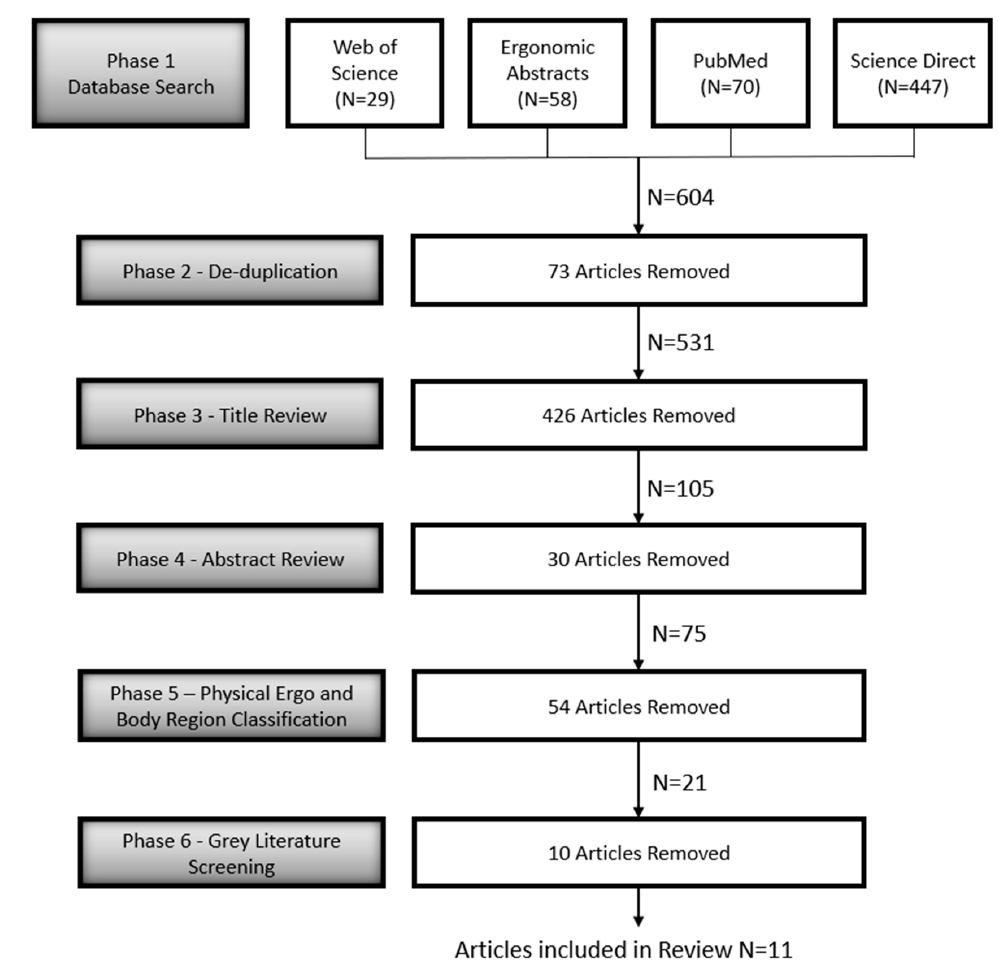
Figure 2. The article selection process.